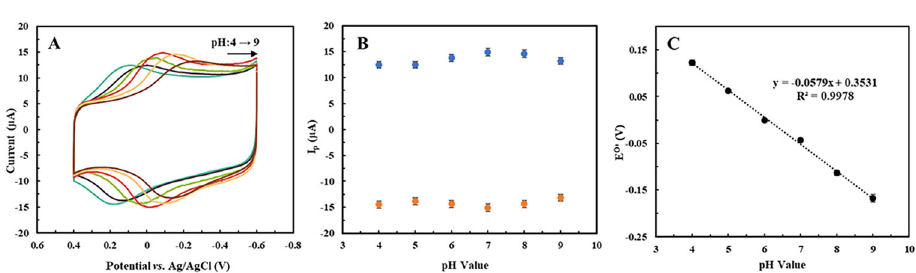
Figure 4. ( A ) CVs of the NF/GDH/IL/mPEG-fMWCNTs in 50 mM PBS at different pH values (from left to right): 4.0, 5.0, 6.0, 7.0 8.0 and 9.0, respectively. ( B ) Plot of peak current ratios versus pH values. ( C ) Plot of formal potential E o ′ versus pH values. versus Ag/AgCl. scan rate of 0.05 V s − 1 , 25 ± 1 °C.